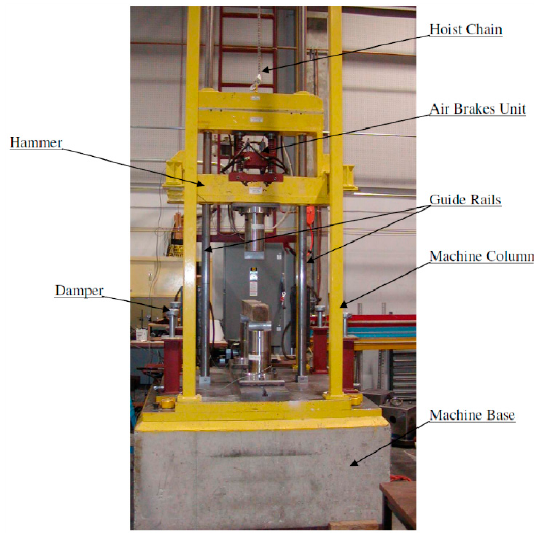
Figure 3. Impact machine.